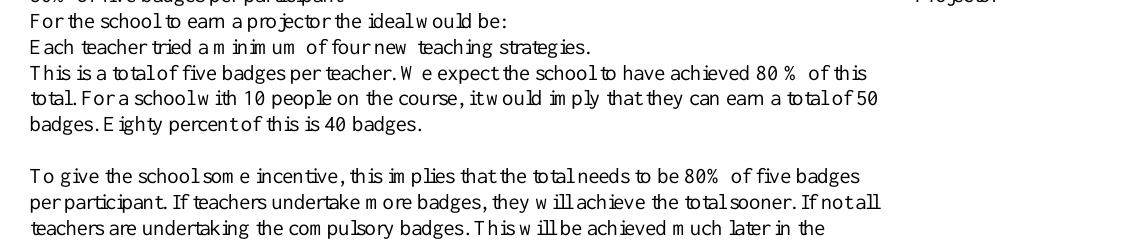
Table 6 School Achievement criteria (Botha, 2014) 80% of five badges per